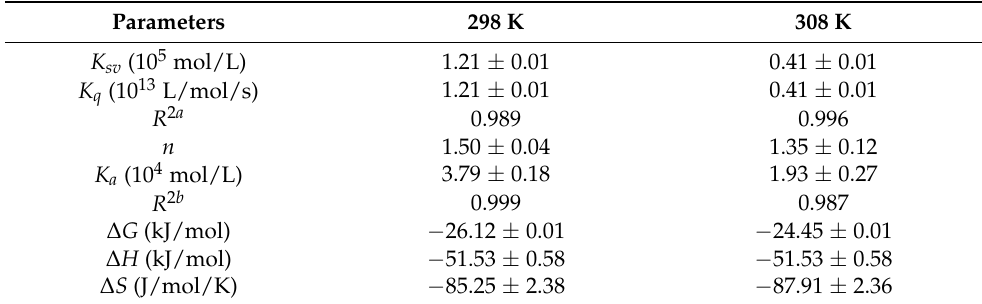
Table 1. Fluorescence parameters of the BSA-Myr system.